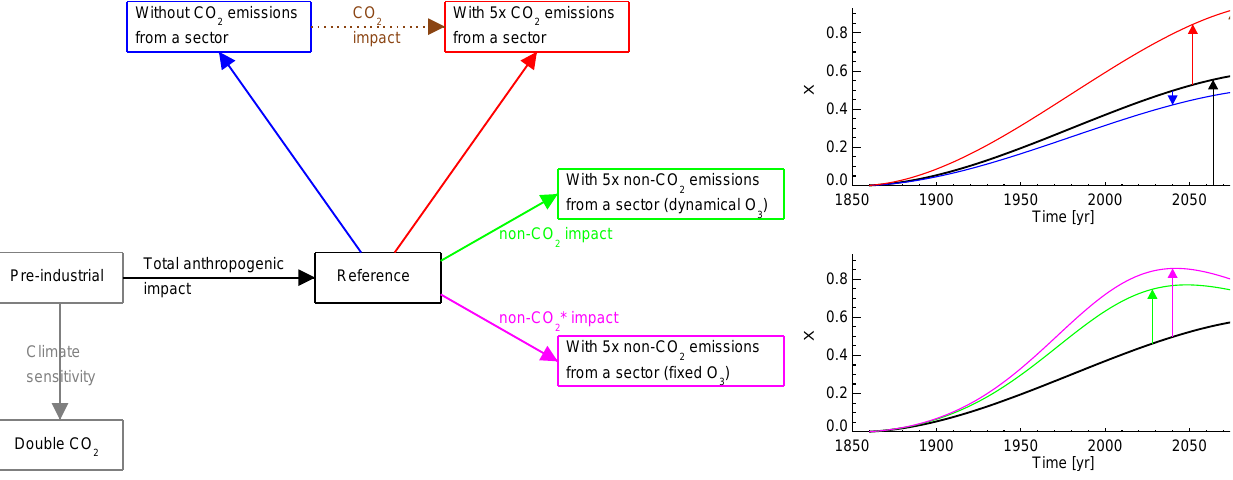
Fig. 4. Schematic representation of the different simulations and impacts (a general impact is represented by X in the ordinate). The black curve (box) denotes the simulation which takes into account all the anthropogenic forcings. The other coloured curves (boxes) represent simulations where the CO 2 or non-CO 2 emissions of one of the transport sectors are modified. The blue curve (box) denotes a simulation without CO 2 emissions of one of the transport sectors, and the red curve (box) denotes a simulation with 5 times the CO 2 emissions of the same sector. The green curve (box) indicates a simulation with 5 times the non-CO 2 emissions from one transport sector, using the dynamical O 3 approach. The purple curve (box) indicates a simulation with the same emissions but using the fixed O 3 approach (see Sect. 2.2.4). A simulation with doubled CO 2 concentration (grey box) is used to derive the climate sensitivity.